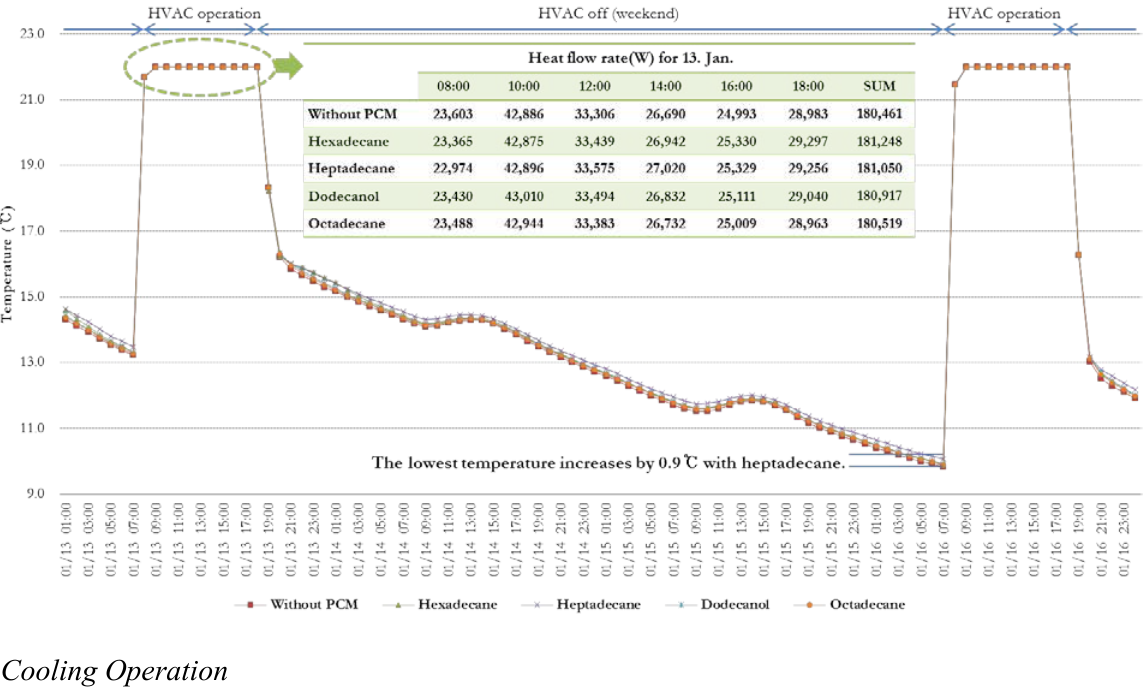
Figure 5. The lowest indoor temperature curve and the heat flow rate for 13 January.